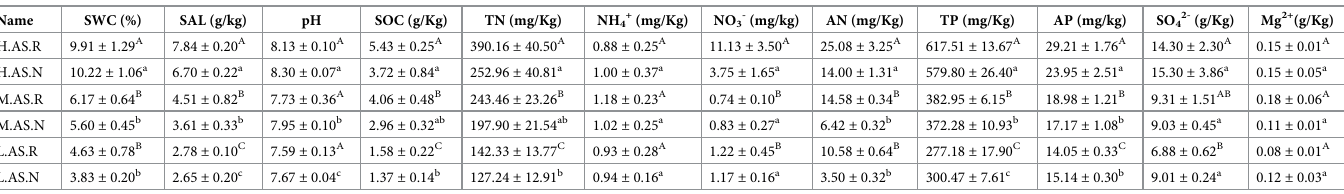
Table 1. The physiochemical properties of rhizosphere and bulk soils associated with Alhagi sparsifolia